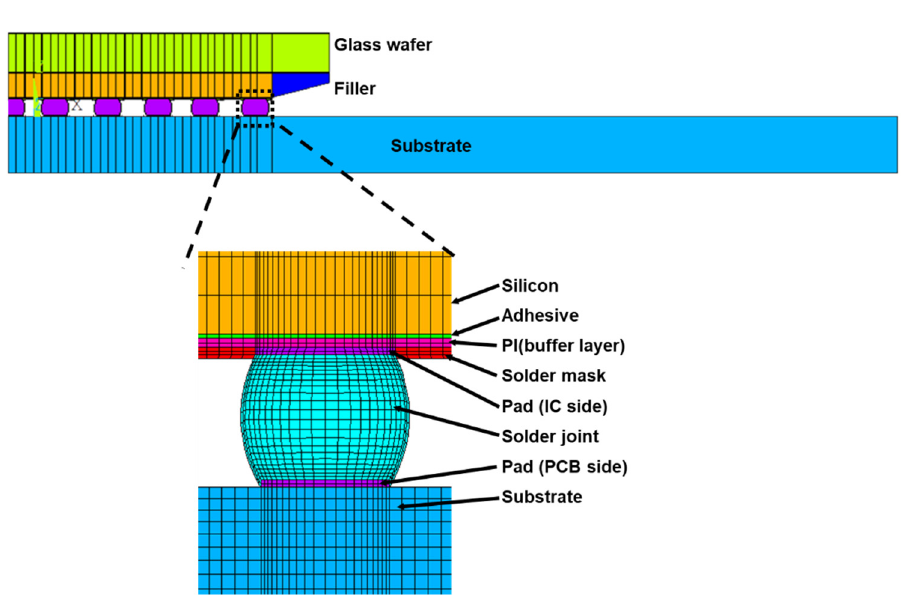
Figure 8. Finite element model for conventional WLCSP and proposed glass WLCSP.